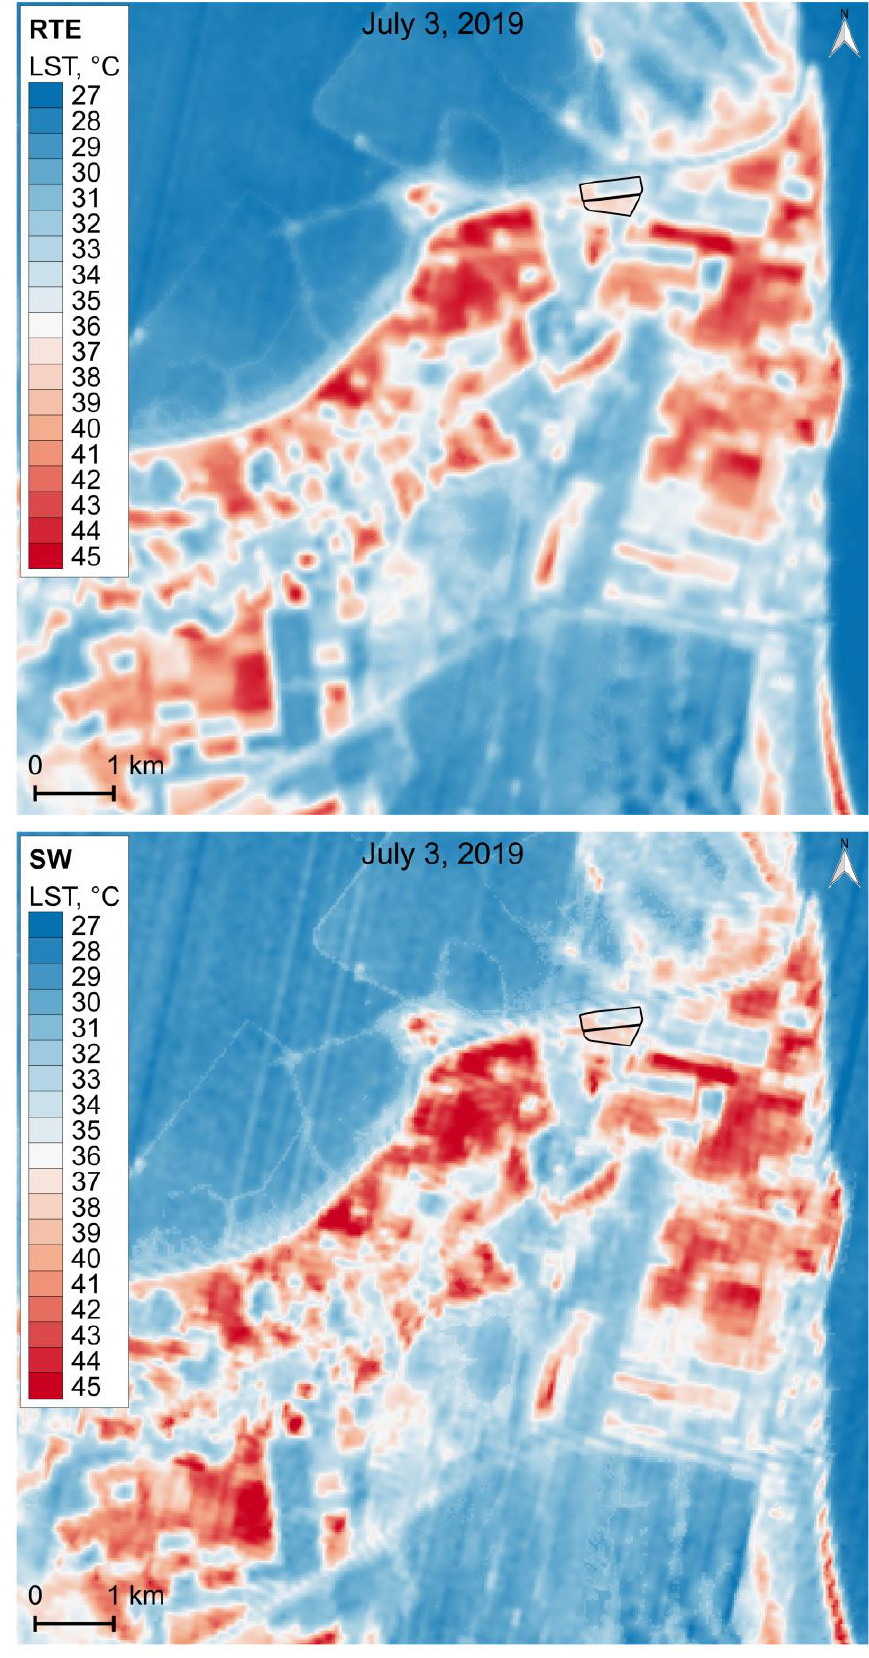
Figure 9. Land surface temperature (LST) maps derived with RTE and SW methods from the 3 July Landsat-8 images.